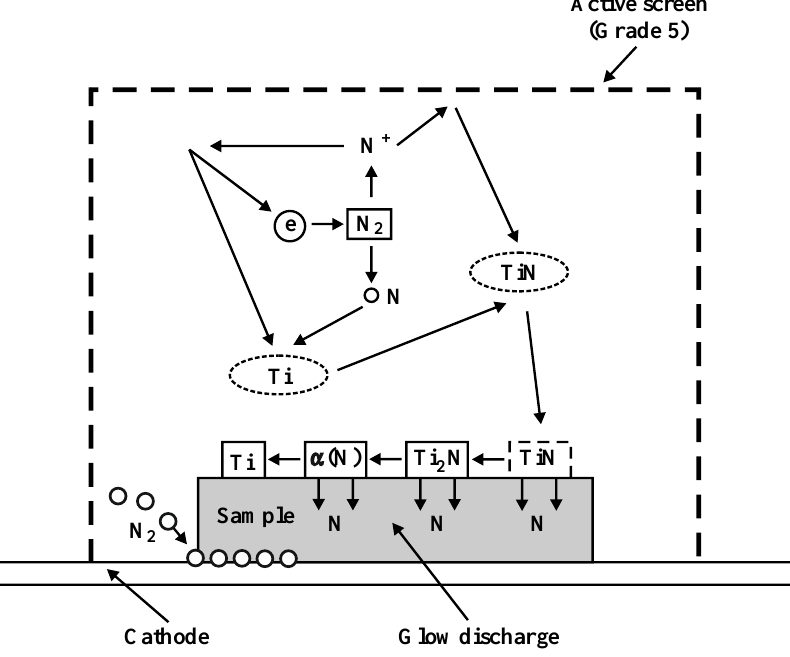
Figure 9. Model of the titanium nitriding process with the use of an active screen.